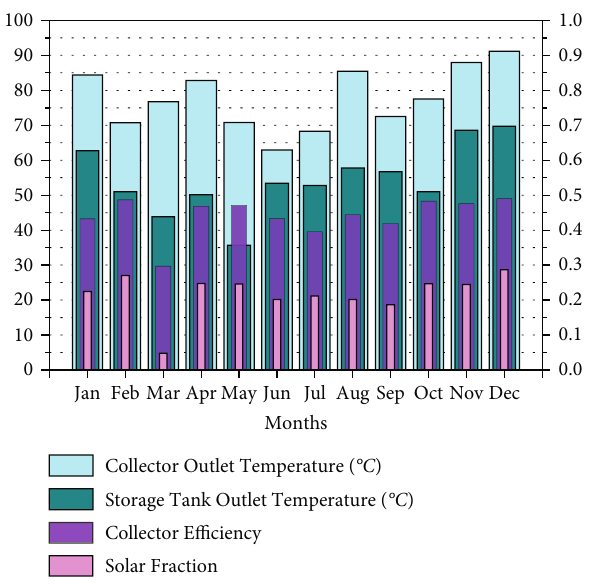
Figure 9: CPC annual performance under Lahore weather.